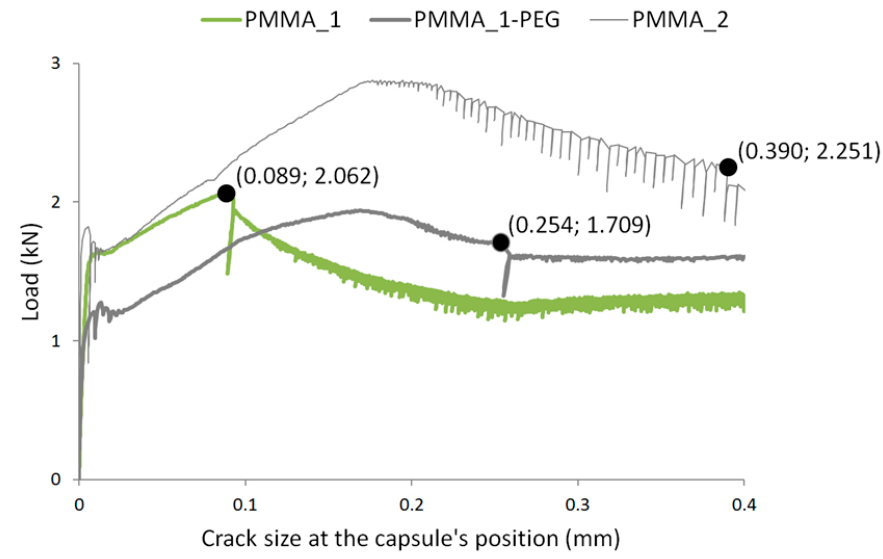
Figure 9. Characteristic load drops at the moment of rupturing of capsules embedded in mortar prims during three-point bending experimental tests. PMMA_1 curve is from the series with thinner walls of 0.31 mm.